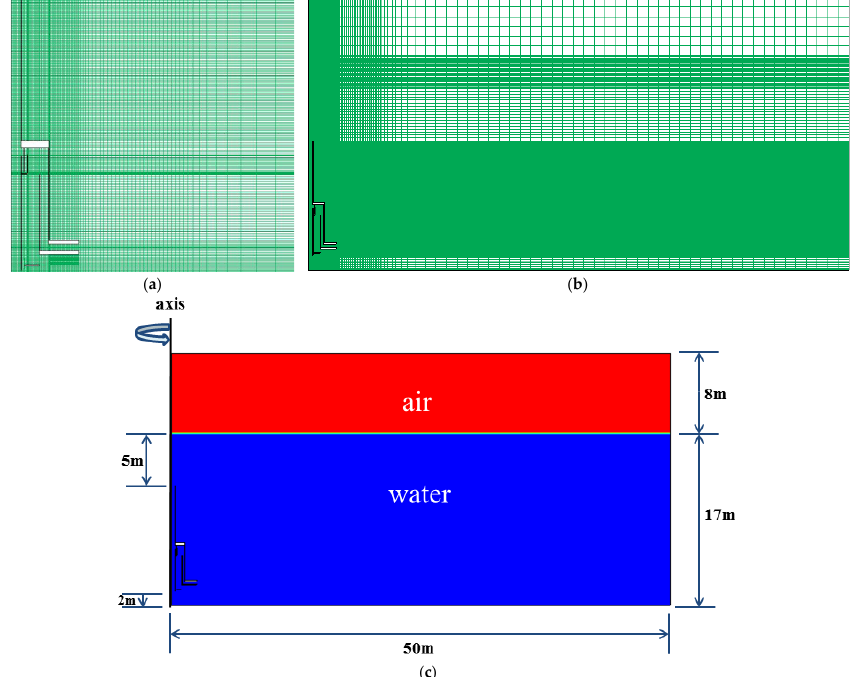
Figure 2. Computational domain grids and volume fraction diagram. ( a ) Local grid; ( b ) global flow field grid; and ( c ) volume fraction. The investigated reservoir was simplified into a cylindrical computational domain with a radius of 50 m and a height of 25 m. The height of the WLA was 10 m, the distance between the lower end of the ascending tube and the domain bottom was 2 m, the radius of the ascending tube was 0.4 m, and the ascending tube was submerged to a depth of 5 m below the free surface. To simulate the flow details of the air piston inside the WLA, the quadrilateral structured grid was locally refined inside the WLA, and the total number of grids was 4.4 × 10 4 . Figure 2a,b show the local grids and global flow field grid, respectively. The air diffuser was defined as the inlet boundary condition, the upper boundary of the computational domain as the outlet boundary condition, the left side of the domain as the symmetry boundary condition, and the other solid walls as the no-slip wall condition. The gas and liquid phase regions at the initial time were specified by flow field initialization, as shown in Figure 2c, with the 8 m gas region above the free surface and the 17 m water region below the free surface. The distribution of the gas and liquid